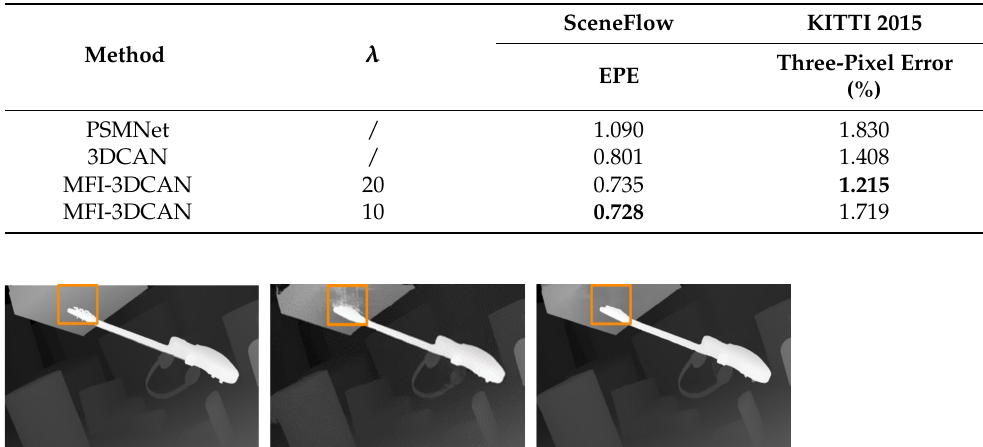
Table 2. Comparison between baseline and 3DCAN.